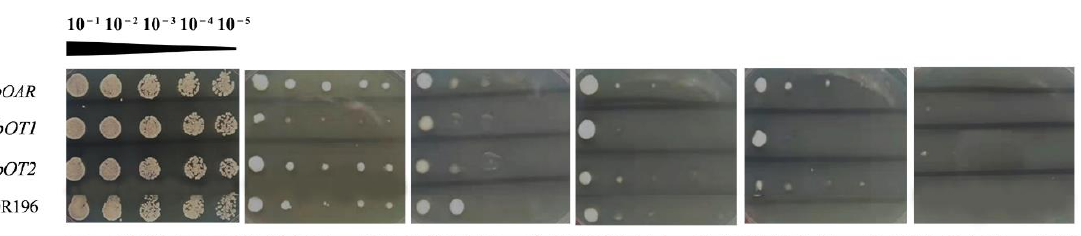
Figure 8. Growth of yeast transformants containing pDR196 empty vector (negative control), FpOAR , HbOT1 , and HbOT2 on SD (-Ura) plates with 0 (CK), 2.4, 2.5, 2.6, 2.7, and 2.8 mmol/L AlCl 3 . The yeast concentrations for each treatment were 10 − 1 , 10 − 2 , 10 − 3 , 10 − 4 , and 10 − 5 , from left to right. Different yeast cells were cultured in liquid medium containing 2.7 mmol/L Al 3+ for 48 h. The OD 600 values of bacteria solution were measured every 2 h and cell growth curves